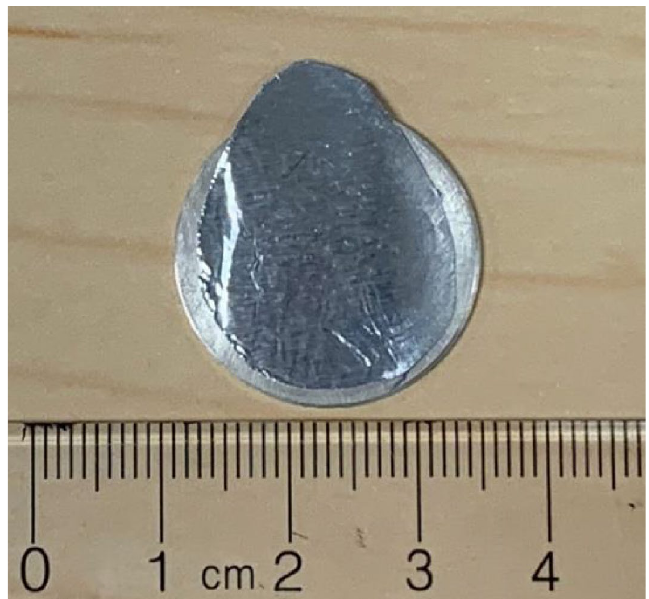
Figure 1. A completed nat Ba sealed cyclotron target ready for